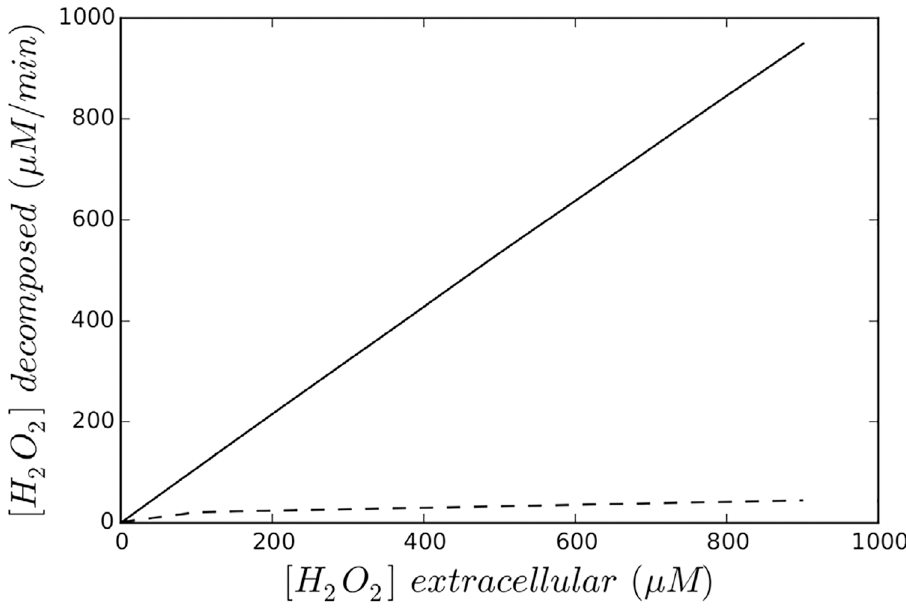
Fig 4. Kinetics of exogenous H 2 O 2 decomposition for 1.5 × 10 8 E. coli cells ml − 1 . The dotted line corresponds to the Cat(-) mutant and solid line corresponds to the Ahp (-)